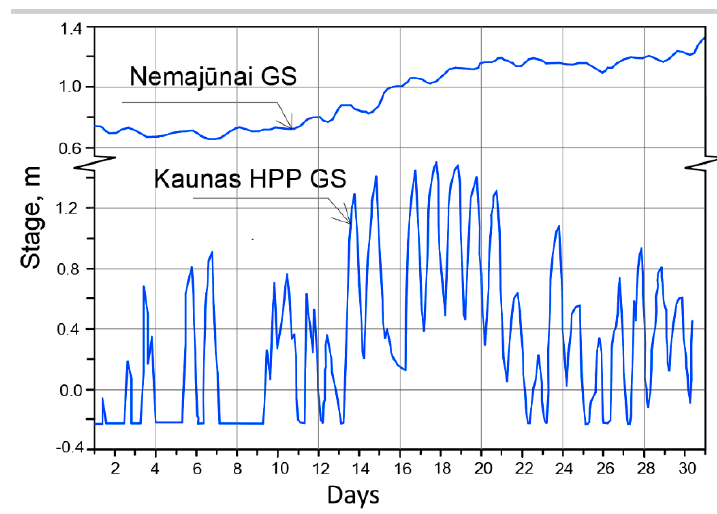
Figure 2. Natural flow (above) and altered (below) hydrographs; saw-toothed pattern hydrographs of the Nemunas River gauging stations upstream and downstream of the Kaunas HPP in Dec. 2017.